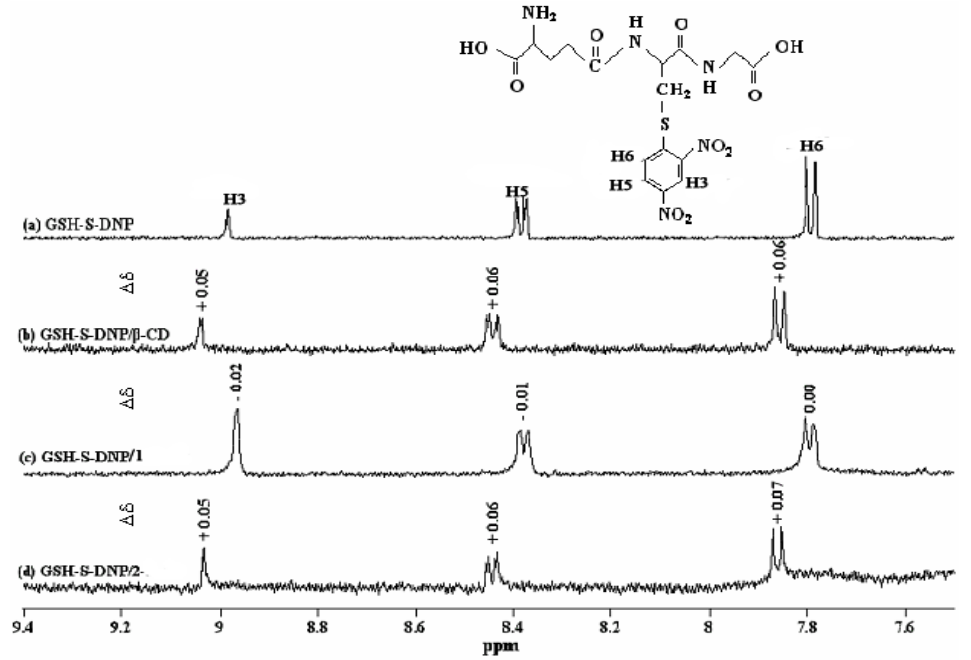
Figure 3. 1 H-NMR spectrum of 3 in the absence (a) and in the presence of (b) β -CD, (c) 1 and (d) 2 in D O at ambient 2